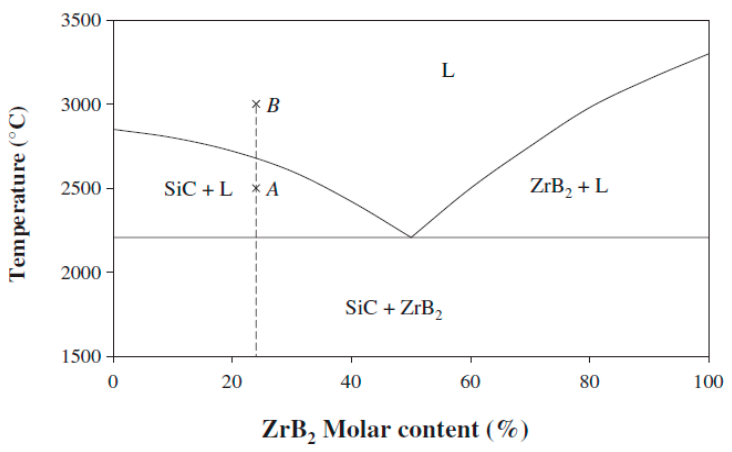
Figure 1. ZrB 2 -SiC phase diagram, where points A and B are particles impacted on the substrate in a completely melted status above liquidus (L) temperature [24].